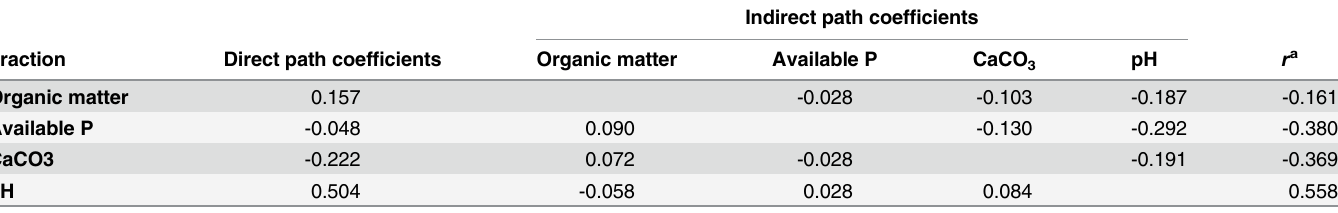
Table 1. Path and correlation coefficients of soil chemical properties to